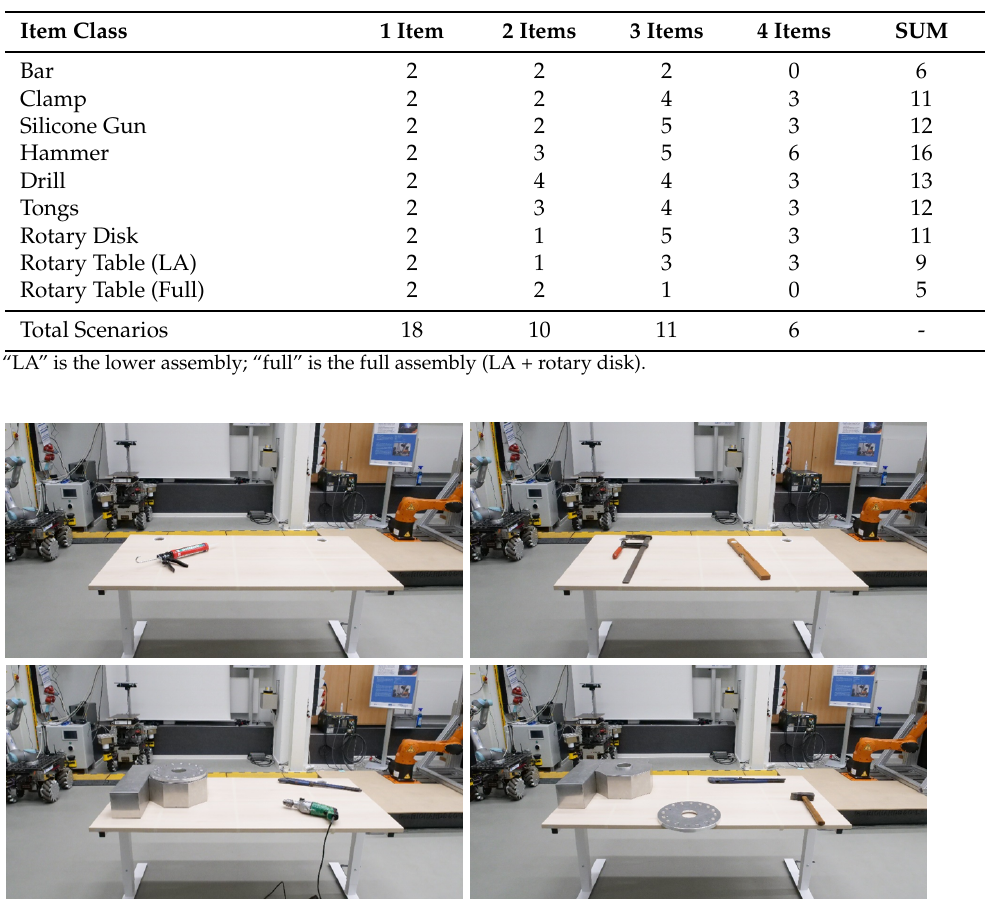
Figure 12. Exemplary four scenarios chosen to depict all items and the table setup (1 item: silicone gun; 2 items: clamp, bar; 3 items: rotary table (full), drill, tongs; 4 items: rotary table (LA), rotary disk, tongs,